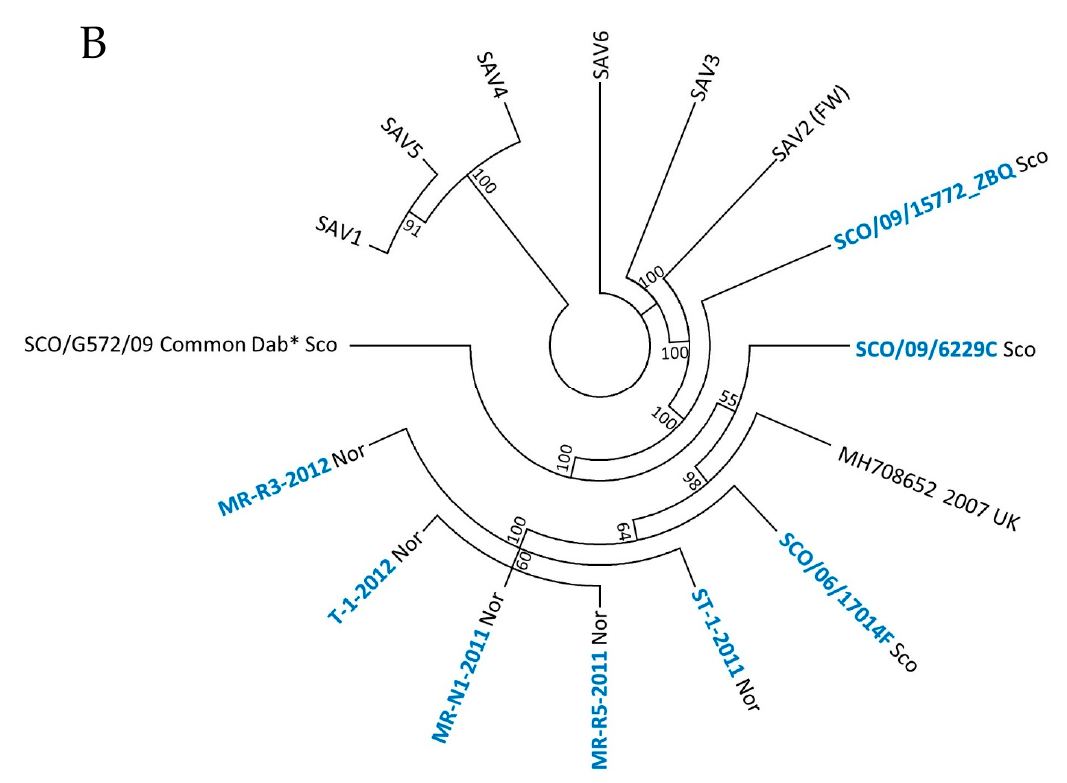
Figure 3. Maximum likelihood trees showing the relationship between strains of SAV1–6. ( A ) The tree includes repre- sentative sequences from each genotype. ( B ) Graphical simplification of ( A ) with all sequences in the clades for SAV1, SAV2 (FW), SAV3, SAV4, SAV5 and SAV6 collapsed to expand the size of the marine SAV2 clade. The tree was inferred using a 11,612 nt nucleotide alignment of SAV genomes including eight new SAV2 generated in the present study (in blue), SAV genomes obtained from GenBank (referred to by the accession number) and Supplementary Material, Dataset S1 presented by Gallagher et al. [11] , marked with (*). Country/geographic area of origin is marked by a suffix at the end of each sequence. Isolate with accession number MH708652 originates from Scotland [25] .